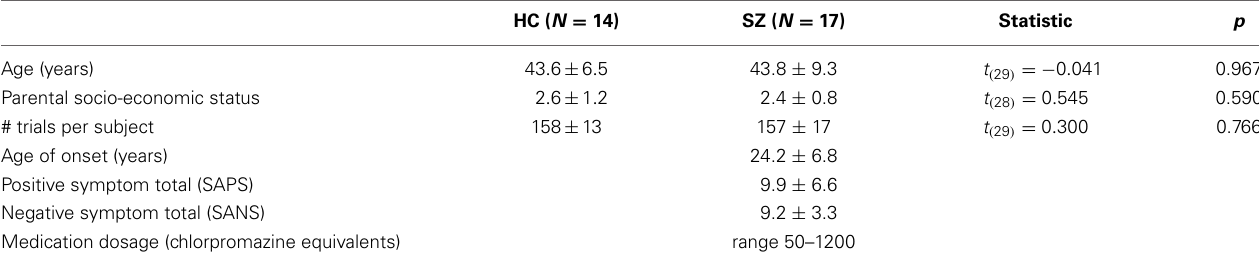
Table 1 | Demographic and clinical variables and between-group comparisons for the healthy control (HC) and schizophrenia patient (SZ) groups.